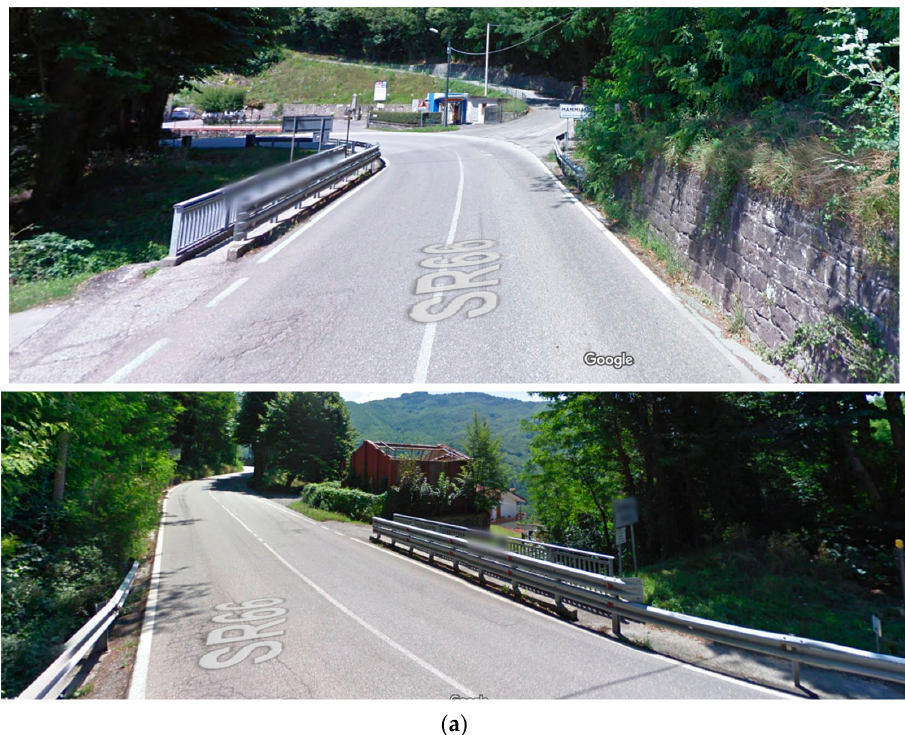
Figure A11. Cont